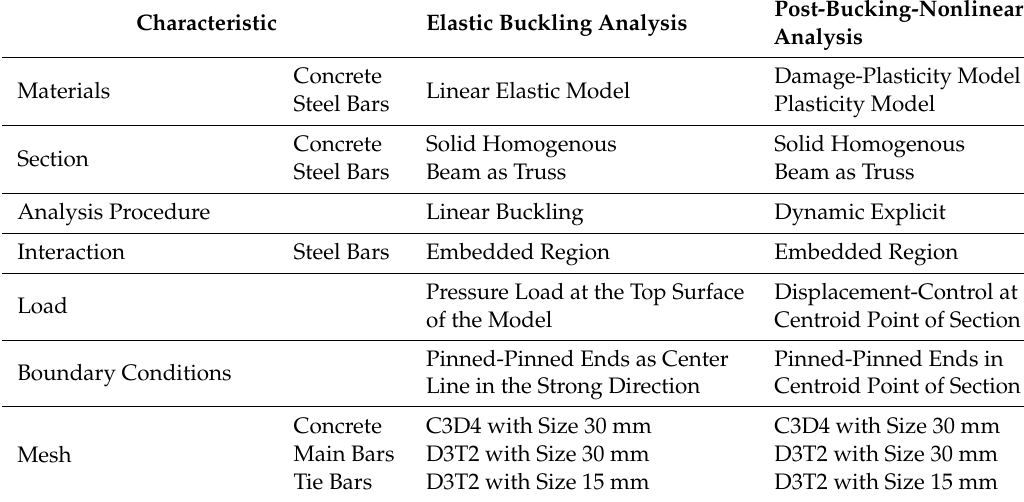
Table 1. Characteristics of finite element (FE) simulation models.